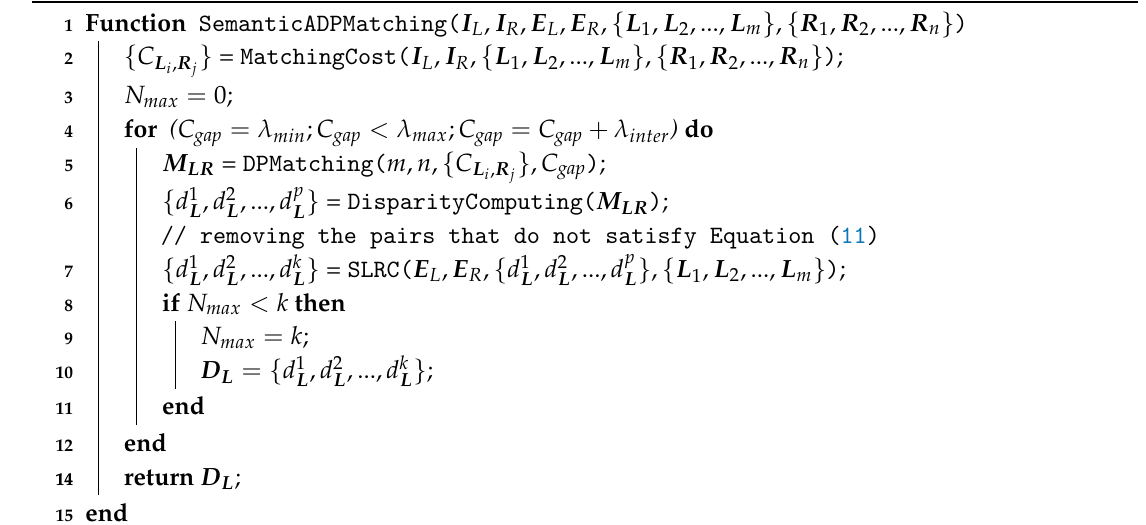
Algorithm 2: Adaptive Dynamic Programming with Semantic Consistency Constraint for Each Pair of Scan-Lines in Stereo